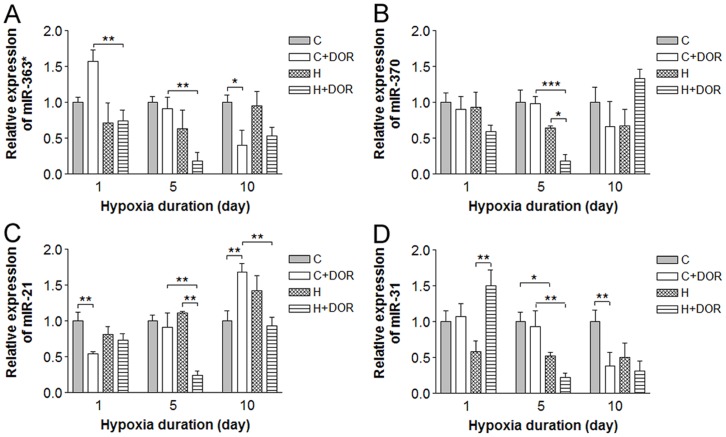
Relative miRNA expression levels of miR-363*, -370, -21 and miR-31 in the rat cortex following 1, 5 or 10 days of hypoxia with or without UFP-512 treatment.C: control; C+DOR: control+DOR agonist UFP-512; H: hypoxia; H+DOR: hypoxia+ DOR agonist UFP-512. *p<0.05, **p<0.01, ***p<0.001. Note that combination of hypoxia and UFP-512 treatment significantly altered the expression levels of miR-363*, -370, -21 and miR-31 in the cortex following 10-day treatment.